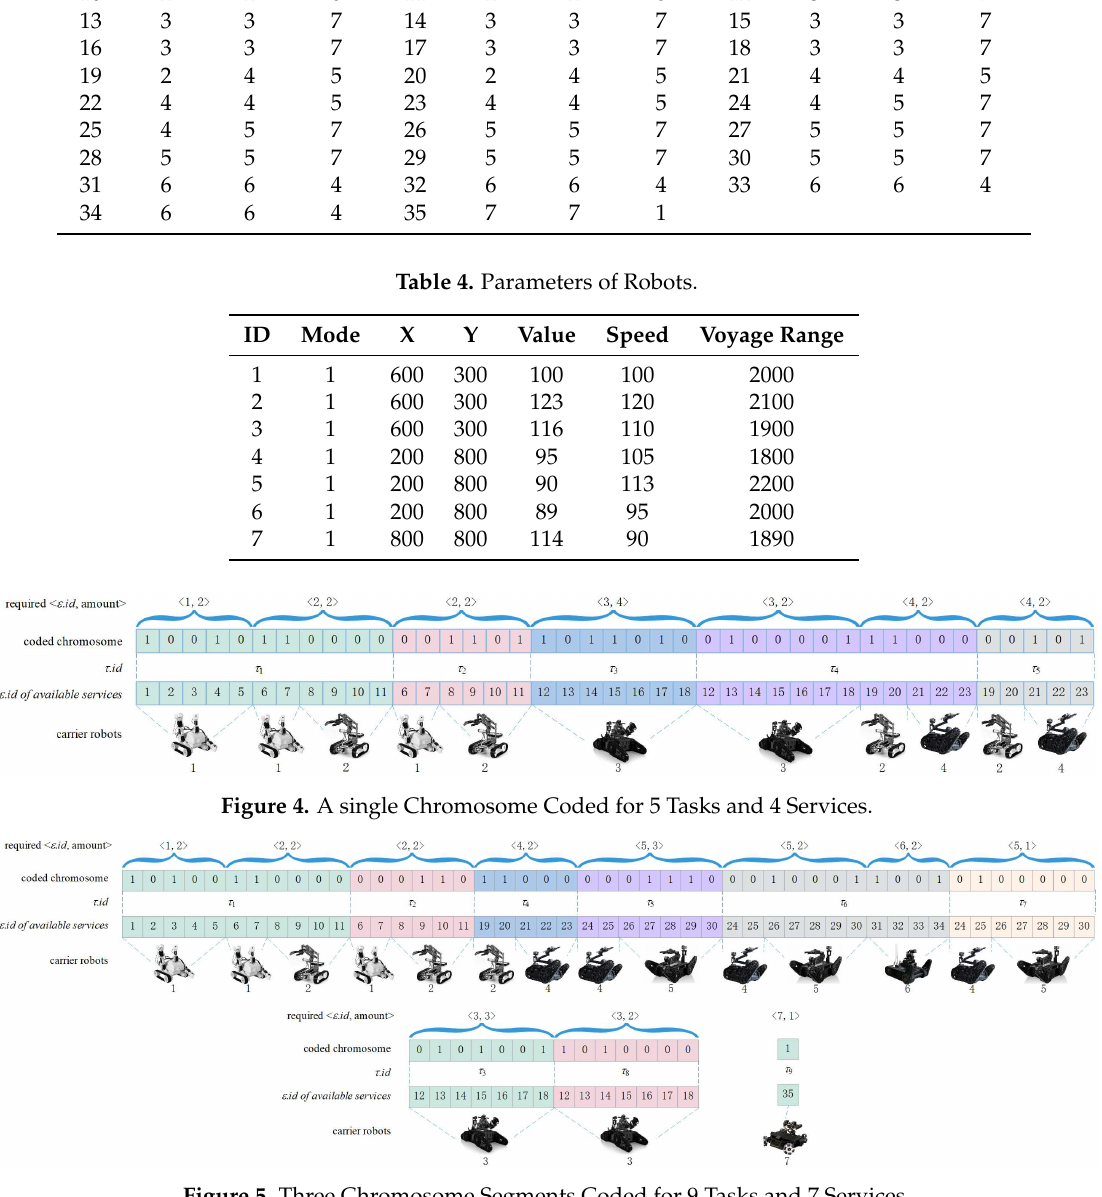
Figure 5. Three Chromosome Segments Coded for 9 Tasks and 7